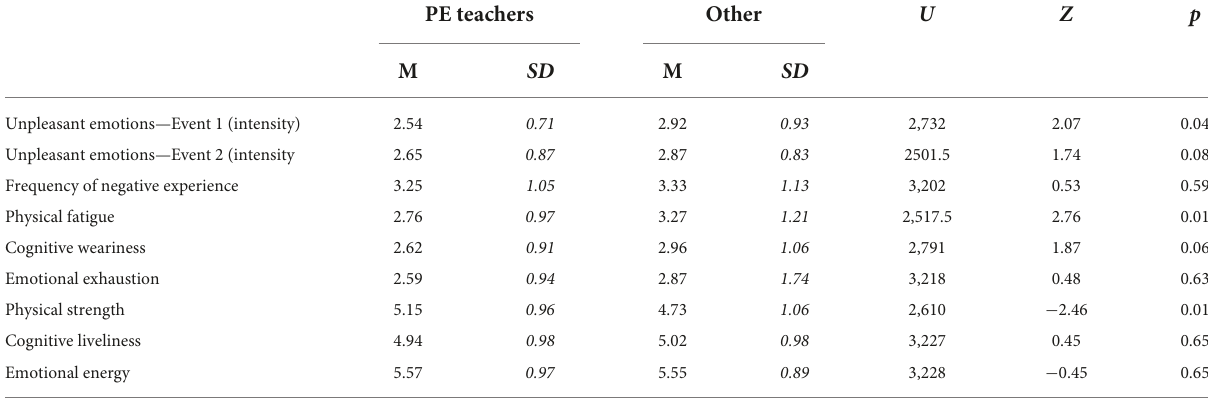
TABLE 3 Comparison of emotions, frequency, burnout, and vigor for physical education (PE) teachers vs. teachers of other subjects (other)—Mann-Whitney U